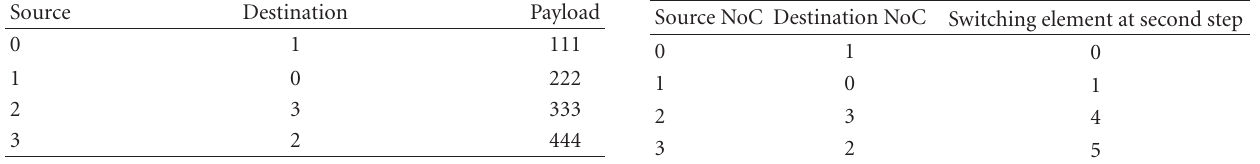
(4) For the FOR loop starting on line #24, Time T 4 = 2 t 5 (here t 5 is constant).